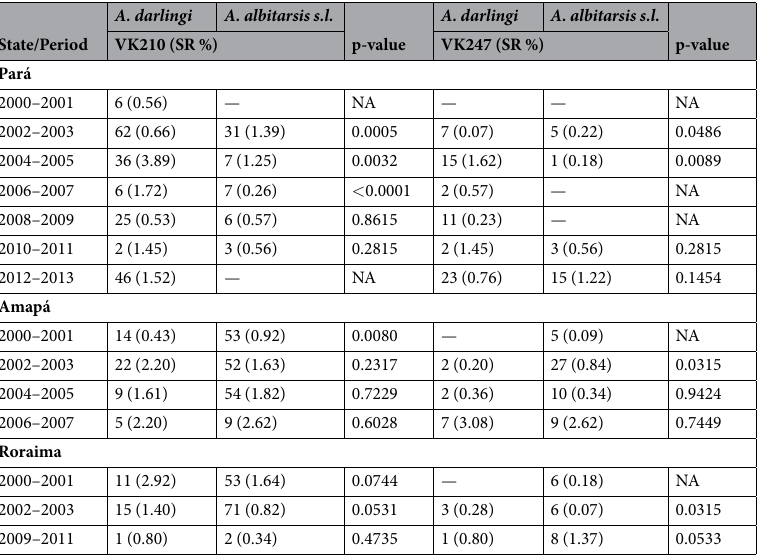
Table 1. Number of CSP infection and SR in the main malaria vectors of Brazilian Amazon. Values that were not possible for analysis in the Binomial test were considered as not applicable